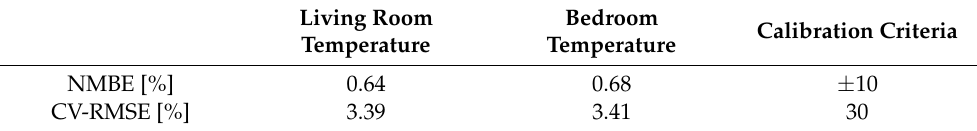
Table 2. Final model compliance with calibration criteria defined in ASHRAE guideline